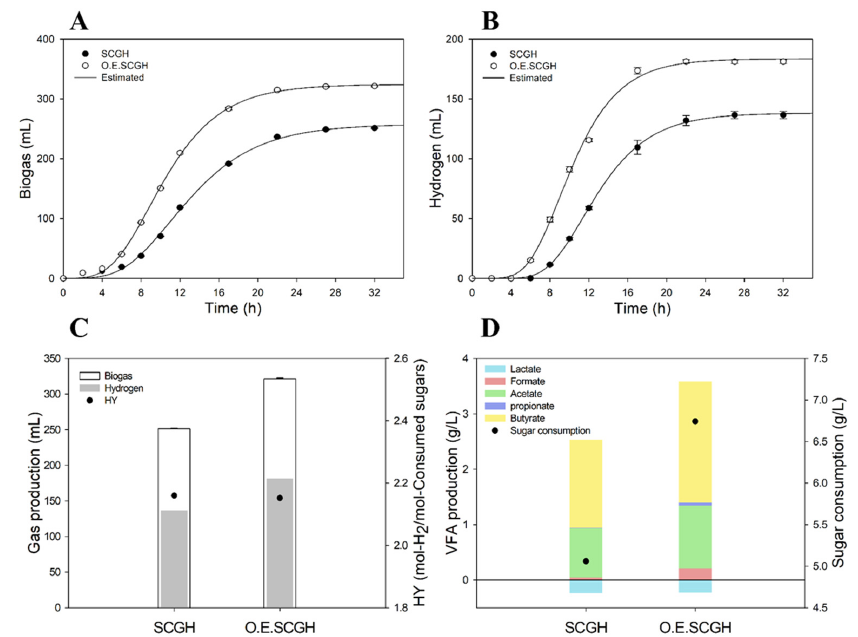
Figure 2. Comparison of dark fermentation productivities based on SCGH, OESCGH media (10 g/L of sugar concentration). ( A ) biogas profile; ( B ) hydrogen profile; ( C ) production amount of biogas and hydrogen, and hydrogen yield; and ( D ) VFA production and sugar consumption.